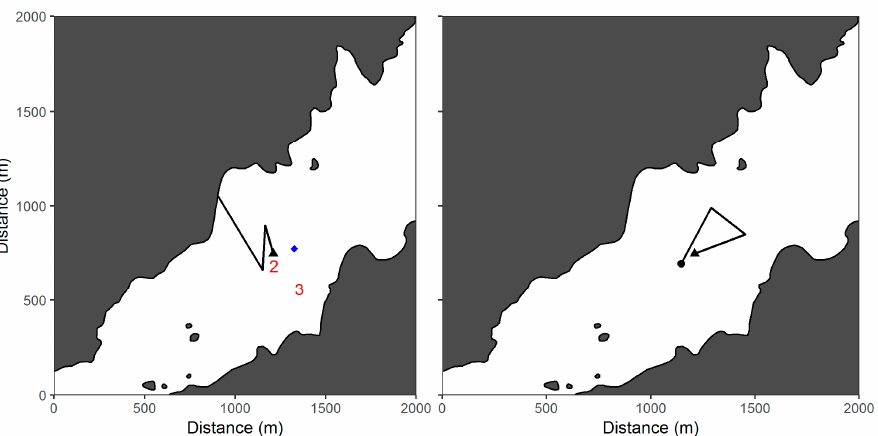
Figure A2. Movements of Fish 12000 (left panel) and Fish 12001 (right panel) tagged with acoustic transmitters and located using an autonomous underwater vehicle and vessel-based tracking in Port Walter, Alaska. The site where the fish were released (black triangle) and the last location of the fish (black dot) are indicated. Vessel-based location estimates are designated by numbers that correspond to the sequential order of the paired AUV estimates (e.g., the second and third AUV location). One location estimate was obtained for Fish 12011 (blue diamond) released during a previous